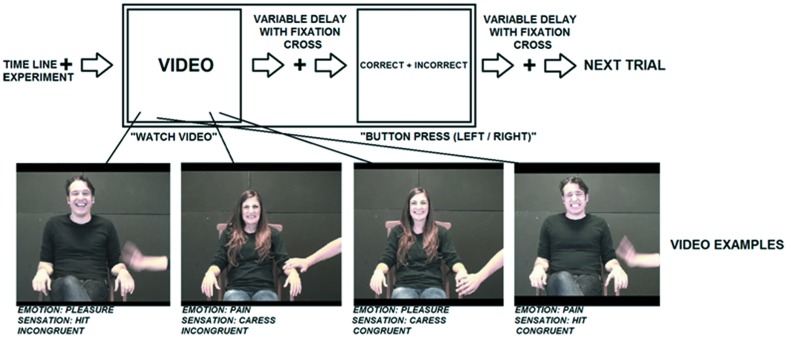
Visualization of the experimental stimuli and procedure.